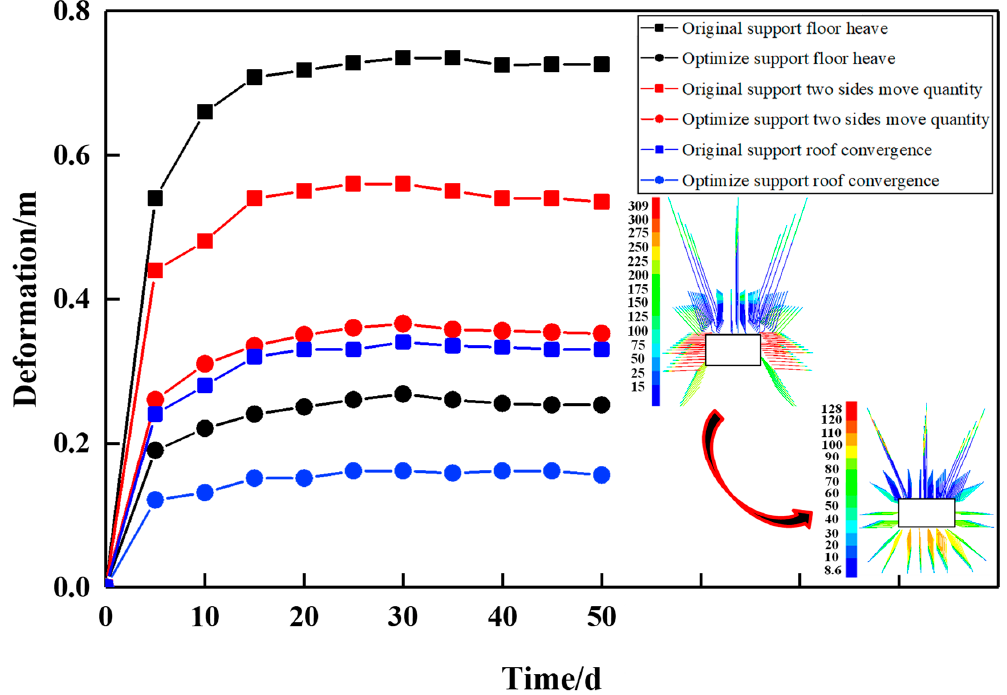
Figure 9. Comparative analysis of correlation characteristics after optimized support.